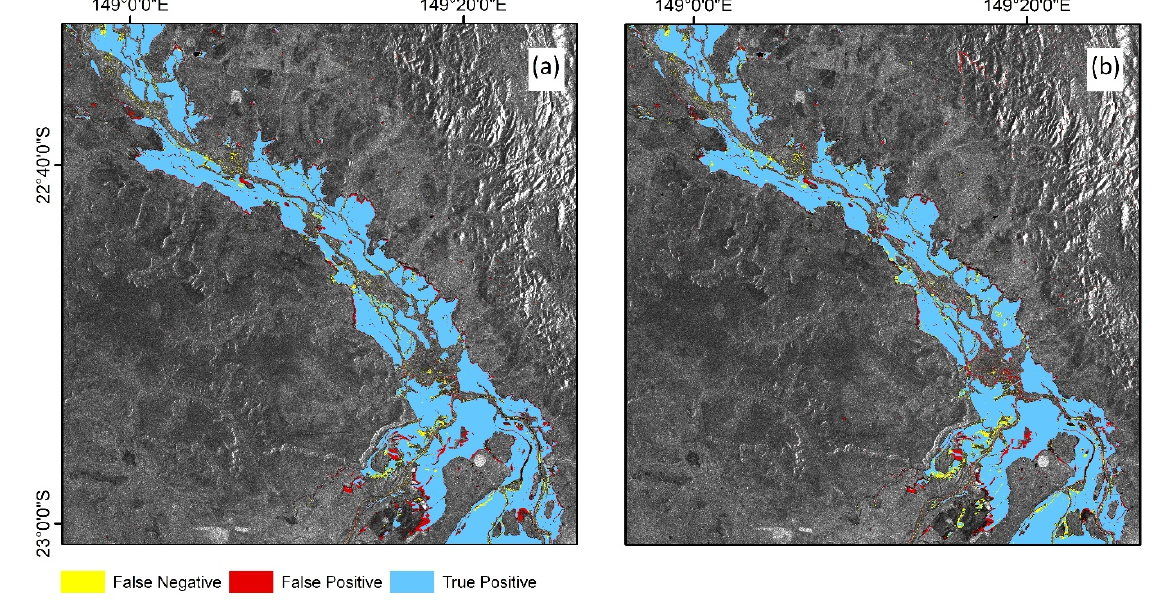
Figure 11. Flood Proxy Maps from ConvLSTM model with classification errors for VV polarization ( a ) and VH polarization ( b ). Table 4. L2 model error sources per Land Cover type (km 2